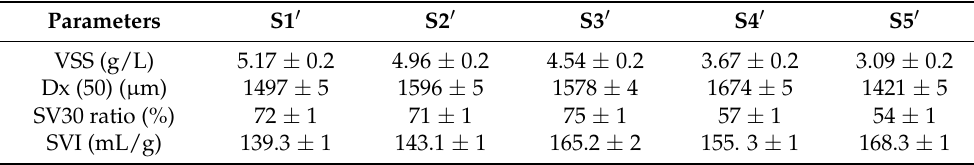
Table 4. Solid-phase changes of excess sludge after